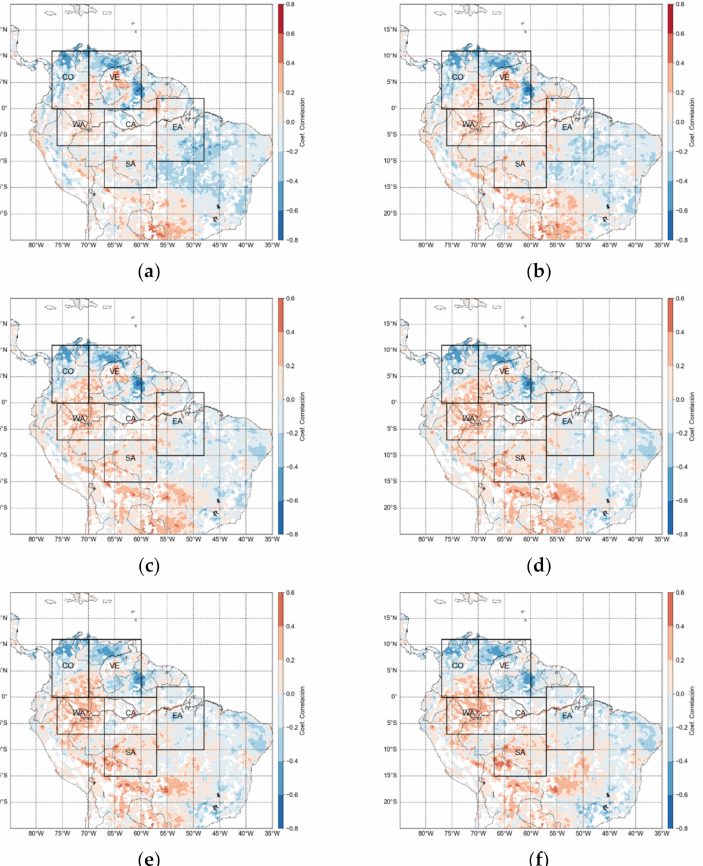
Figure 9. Spatial pixel-by-pixel lagged-correlations between the EP index (leading) and standardized SMOS (lagging) monthly data: ( a ) 0 lag; ( b ) 1-month lag; ( c ) 2-month lag; ( d ) 3-month lag; ( e ) 4-month lag; and ( f ) 5-month